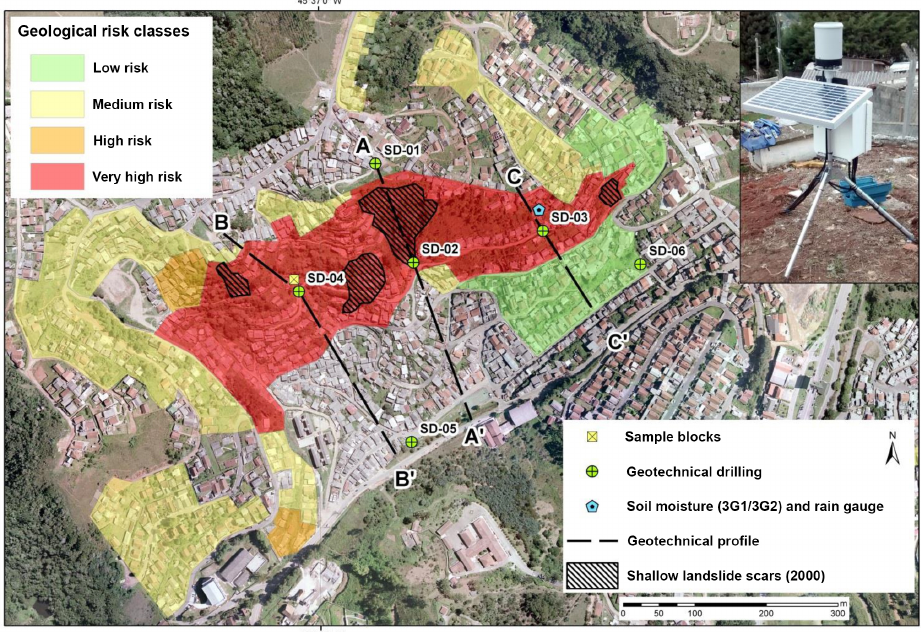
Figure 3. Satellite image of the study site showing the location of monitoring instruments (symbols), geotechnical transects (dotted lines along the slopes), landslide susceptibility areas indicating the level of risk (areas shaded in yellow, orange and red) and scars of previous shallow landslides (black cross-hatched area).